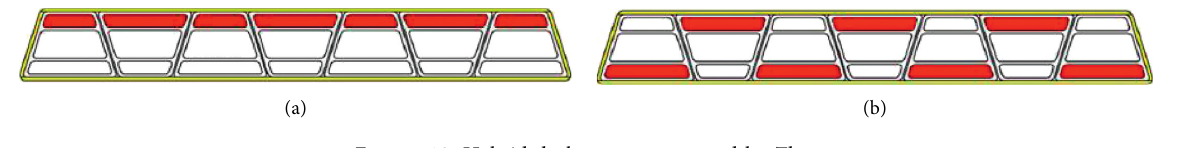
Figure 10: Hybrid deck system proposed by Zhu.